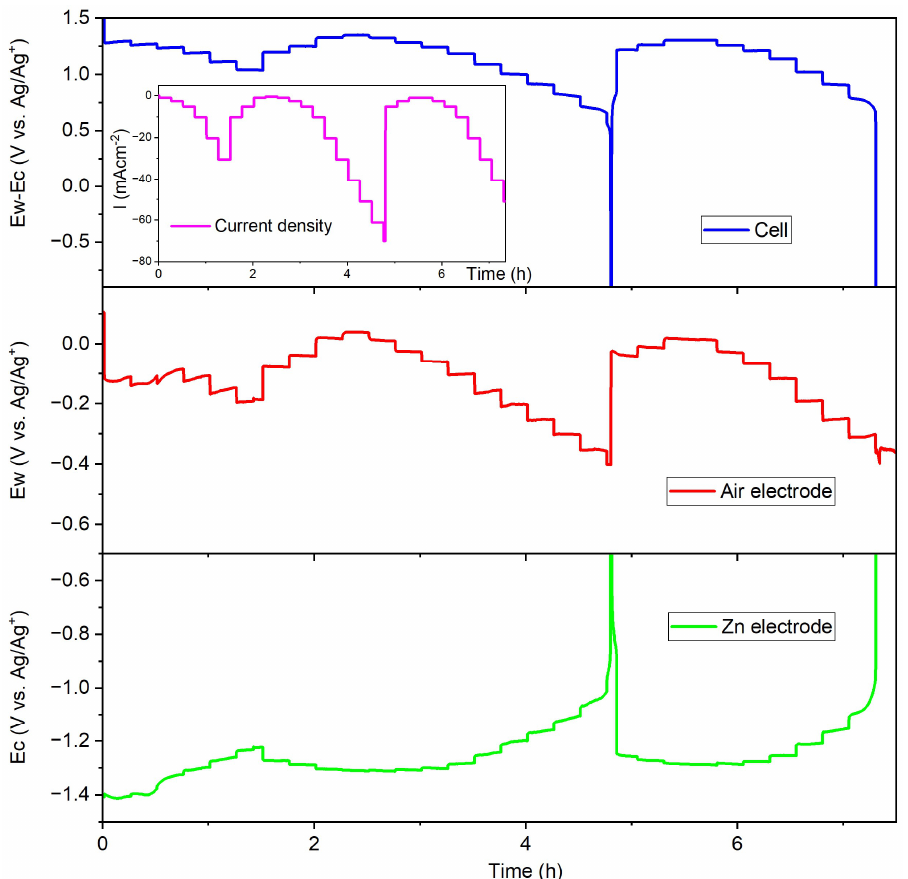
Figure 3. Voltage curves of the entire cell (Ew–Ec), counter (Ec), and working electrodes (Ew) versus time at different current density values for a Zn/air liquid battery. The working electrode was a commercial air electrode, and a Zn plate was the counter. Inset: Current density applied with time. The pseudo-reference electrode was an Ag wire. Electrolyte: ~1 mL of 6 M KOH